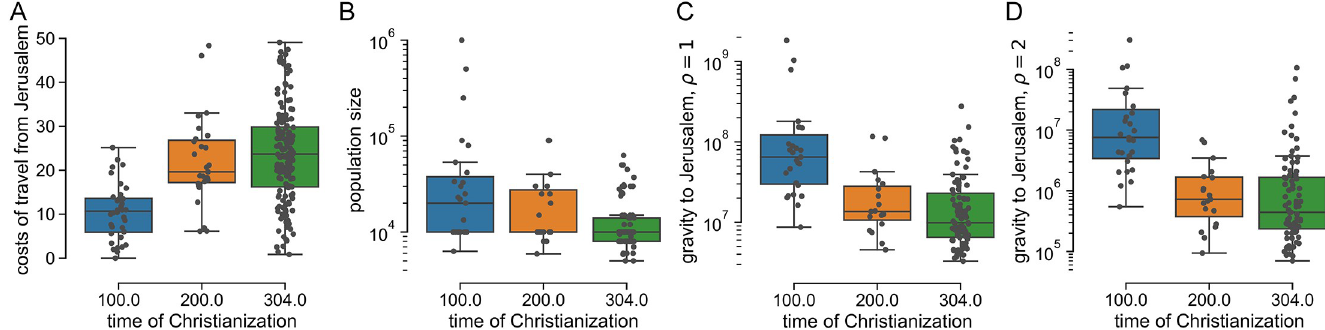
Fig 2. Factors of the time of Christianization. (A) Travel expense to Jerusalem, (B) population size, (C) gravity model with ρ = 1, and (D) gravity model with ρ = 2. The boxes show the median and the quartiles, the whiskers extend past the quartiles by 1.5 interquartile range.